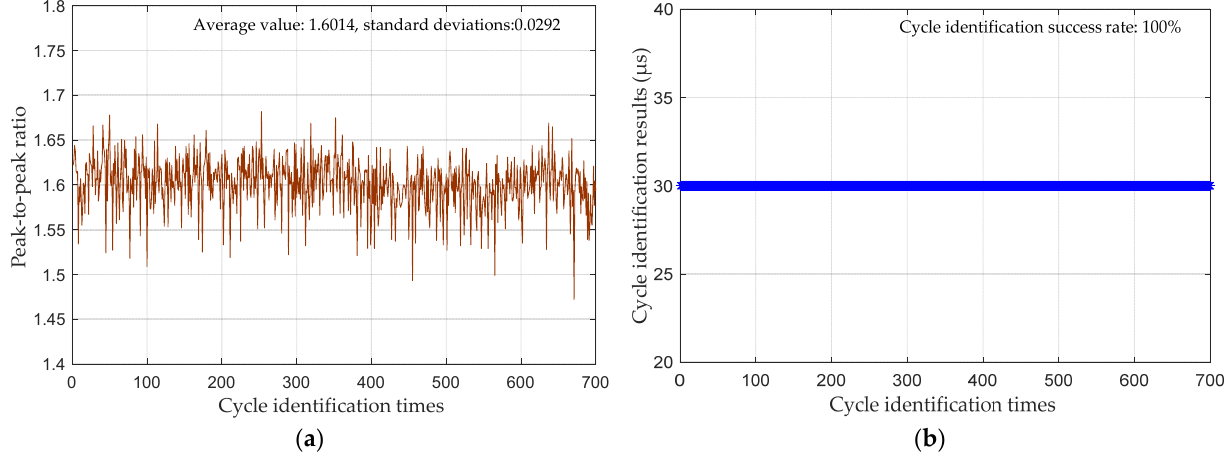
Figure 16. Results of cycle identification for Test 2: ( a ) peak–peak ratio; ( b ) cycle identification result.